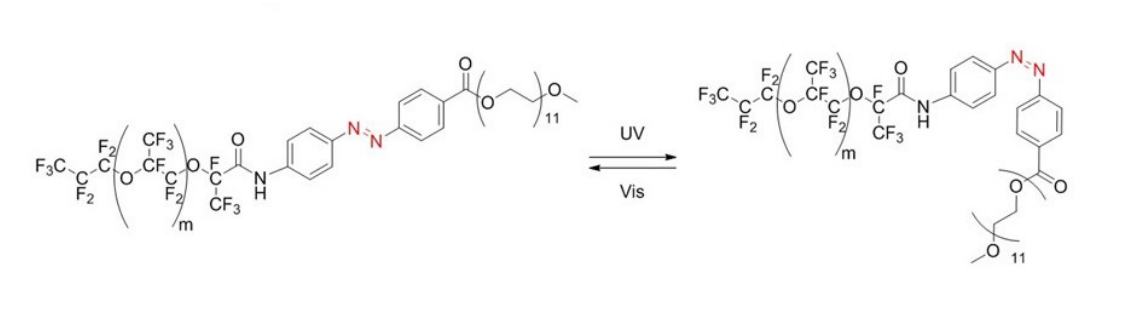
Figure 2. Stable trans form ( left ) and metastable cis form ( right ) of the synthesized KryAz600 molecule; trans to cis transition occurs under UV irradiation and back to trans occurs under visible